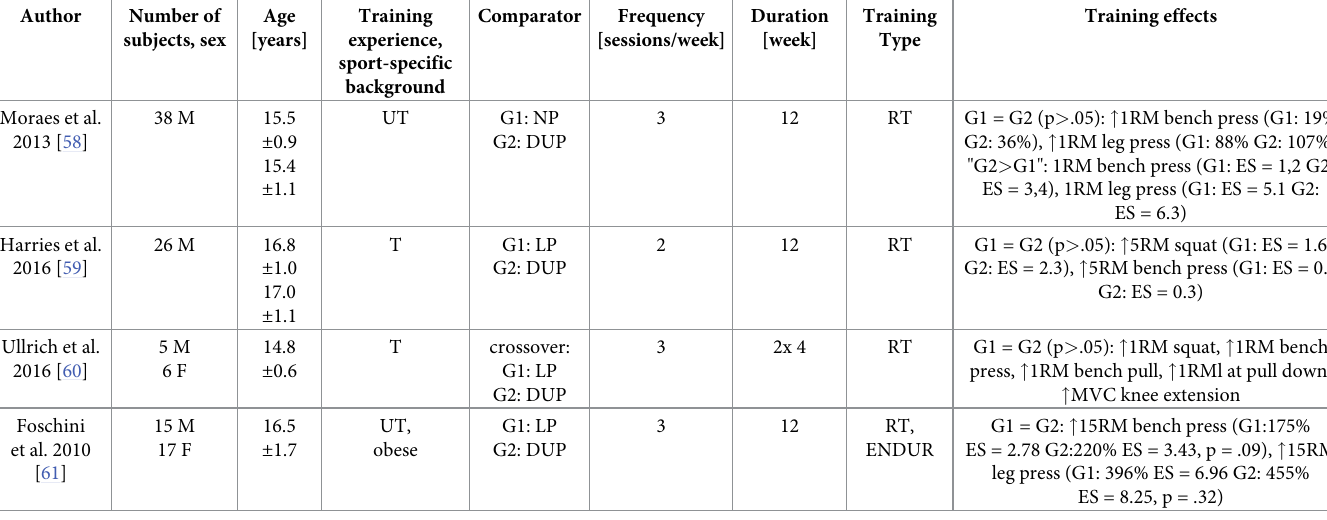
Table 5. Influence of the moderating variable ‘periodization’ on resistance training induced improvements in components of physical